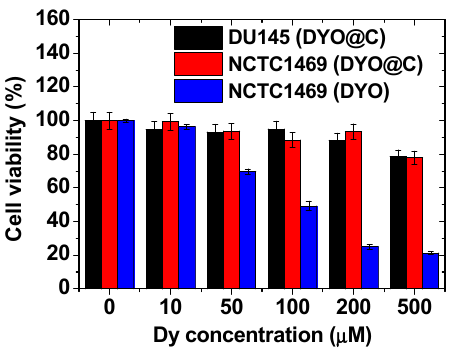
Figure 6. Cell viabilities of DYO@C nanoparticles in NCTC1469 and DU145 cells and those of DYO nanoparticles before carbon coating in NCTC1469 cells.